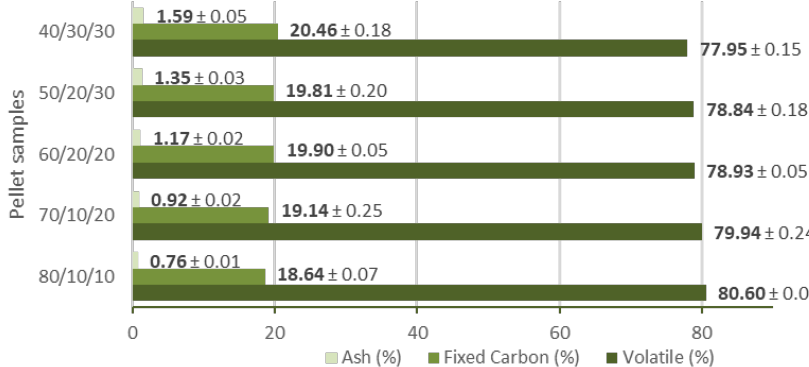
Figure 4. Results from TGA analysis of produced pellets based on their dry